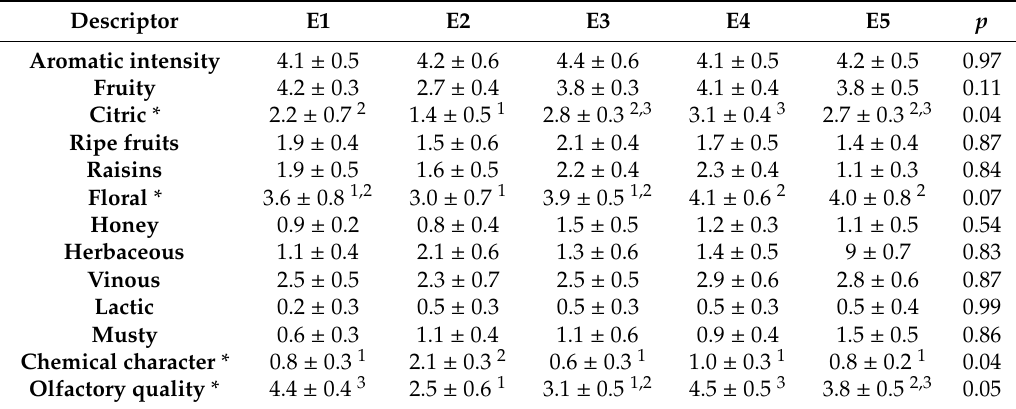
Table 4. ANOVA of sensory scores of wines for vintage 01 made under di ff erent fermentation conditions, as described in the text. Mean values and standard deviations are